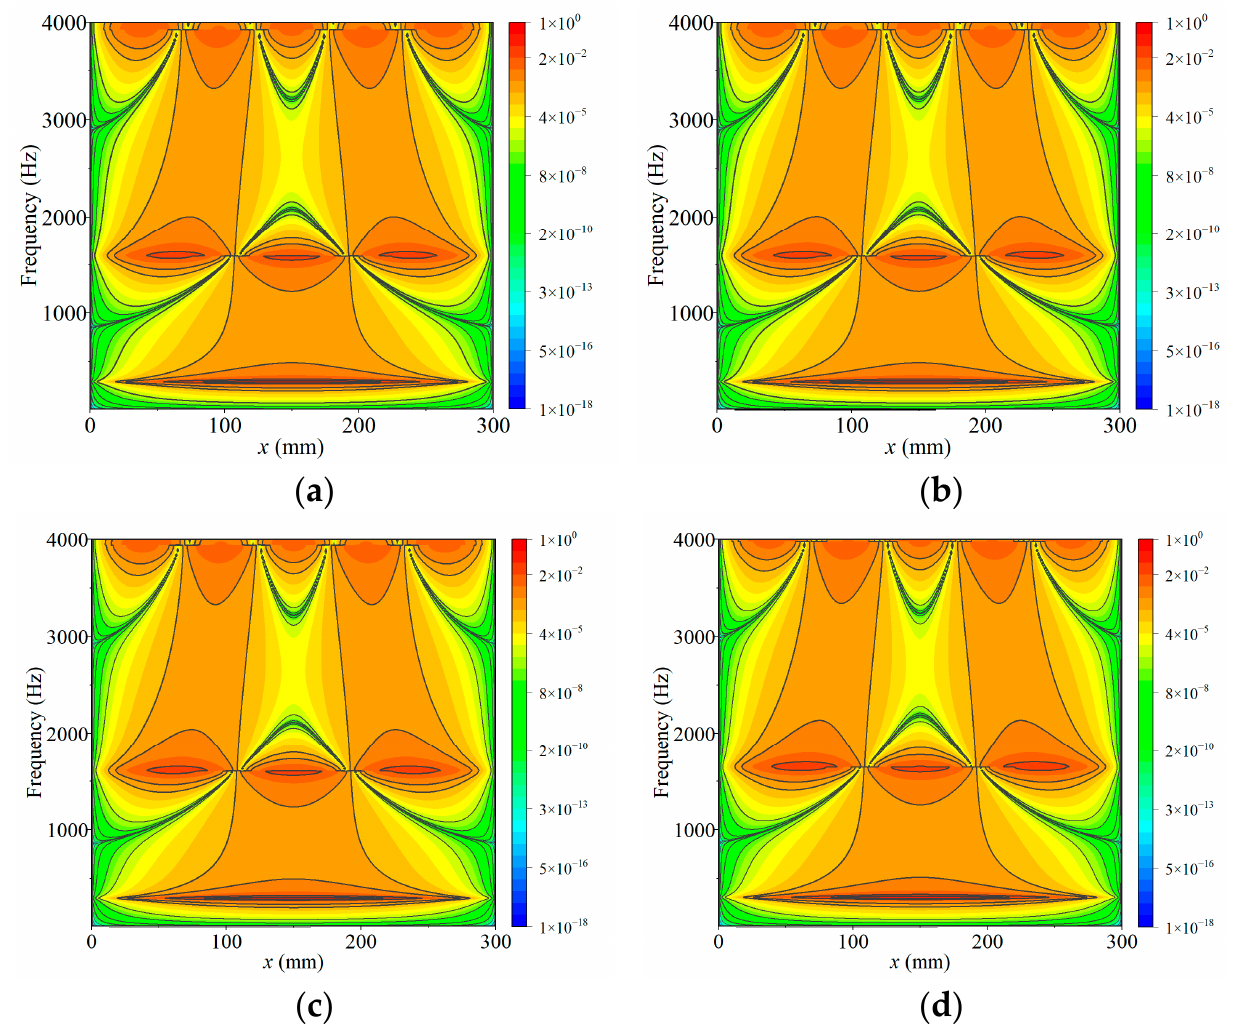
Figure 5. PSD contour of acceleration in the z-direction under different static loads (g 2 /Hz): ( a ) case ref; ( b ) case a 1; ( c ) case a 2; ( d ) case a 3.